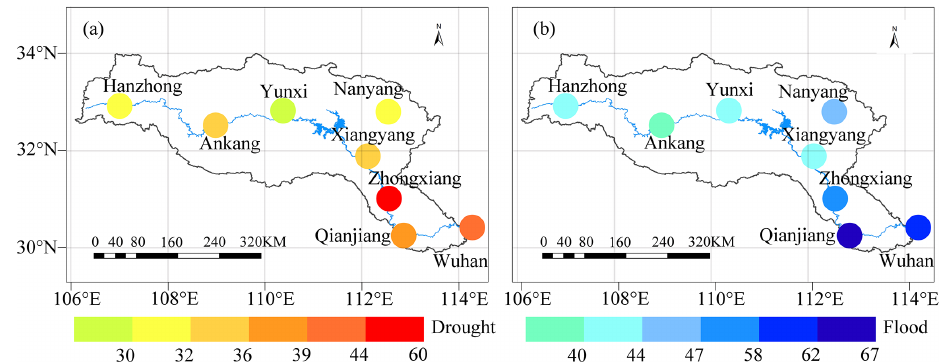
Figure 5. Spatial distribution of the total years of extreme (grade 5) droughts (a) and extreme (grade 1) floods (b) in the HRB during 1426–2017.